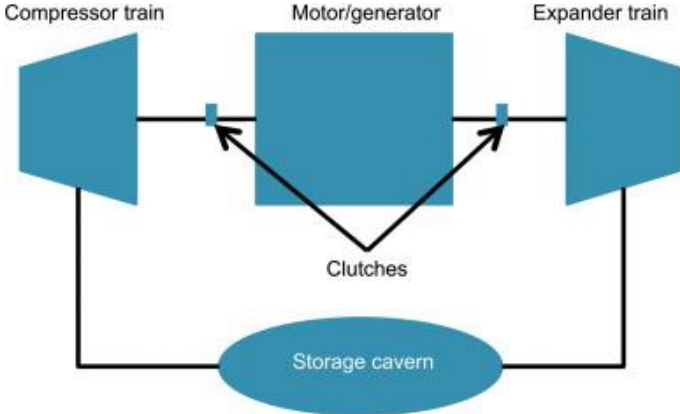
Figure 1. Schematic representation of a Compressed Air Energy Storage (CAES) System